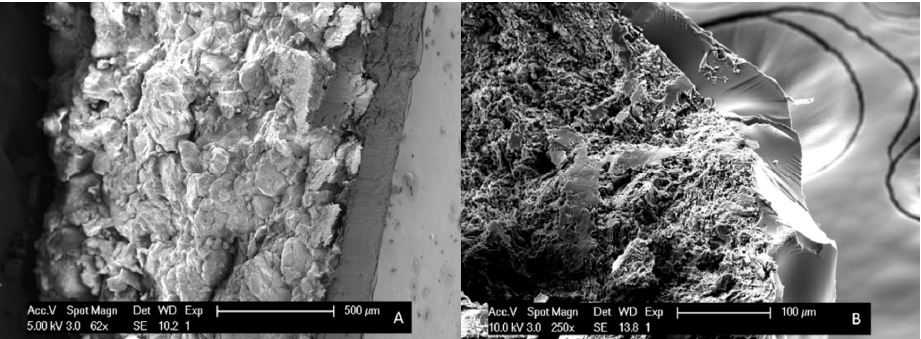
Figure 8. SEM images of ( A ) a MIC_45_PVP-VA_MeOH surface coated MCC tablet, employing the intermittent spraying procedure IM1; ( B ) a MIC_45_PVP-VA_MeOH coated MCC bead.